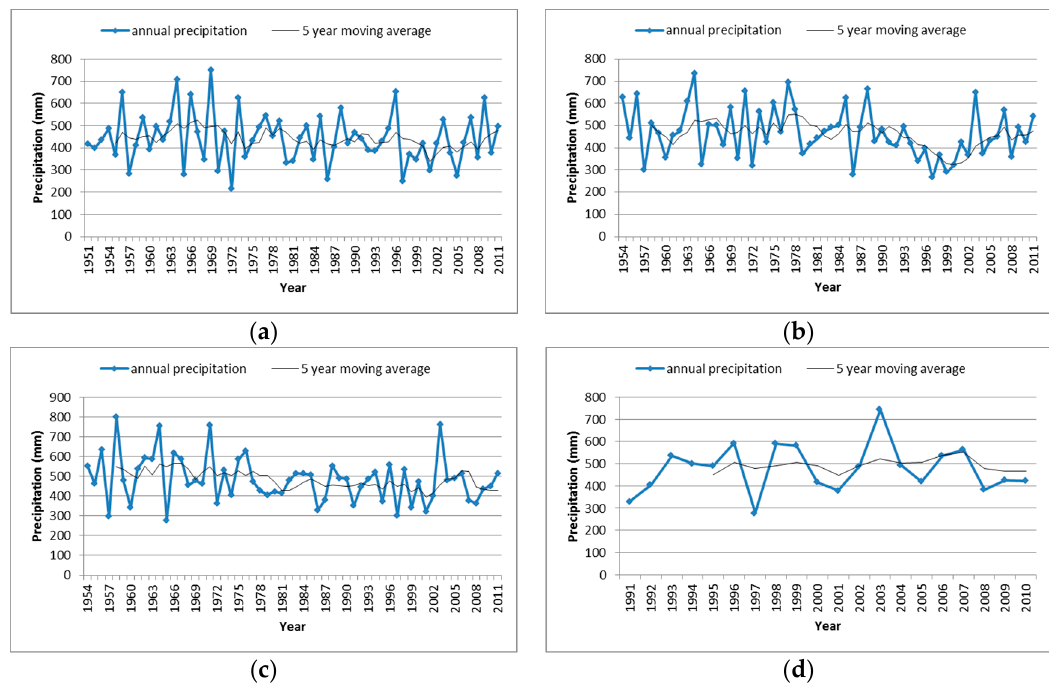
Figure 4. Time series of precipitation variations at meteorological stations in the Fenhe River basin. ( a ) Annual precipitation curve for the Taiyuan area from 1951 to 2011; ( b ) Annual precipitation curve for the Jiexiu area from 1954 to 2011; ( c ) Annual precipitation curve for the Linfen area from 1954 to 2011; ( d ) Annual precipitation curve for the Houma area from 1991 to 2011.